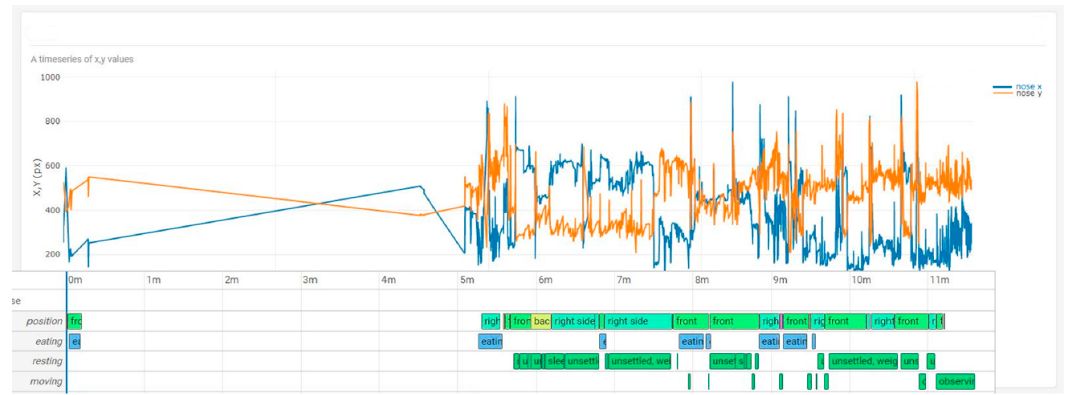
Figure 4. x,y time series plus behaviour score of the horse on day 2 post colic surgery. The